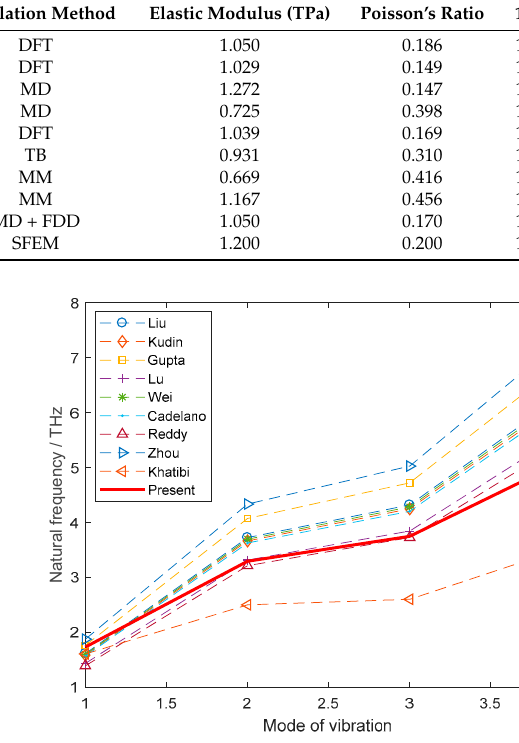
Figure 3. Comparison natural frequencies of present model with that in literatures. Table 1. Comparing the natural frequencies obtained from present model with that in references [26– 34].